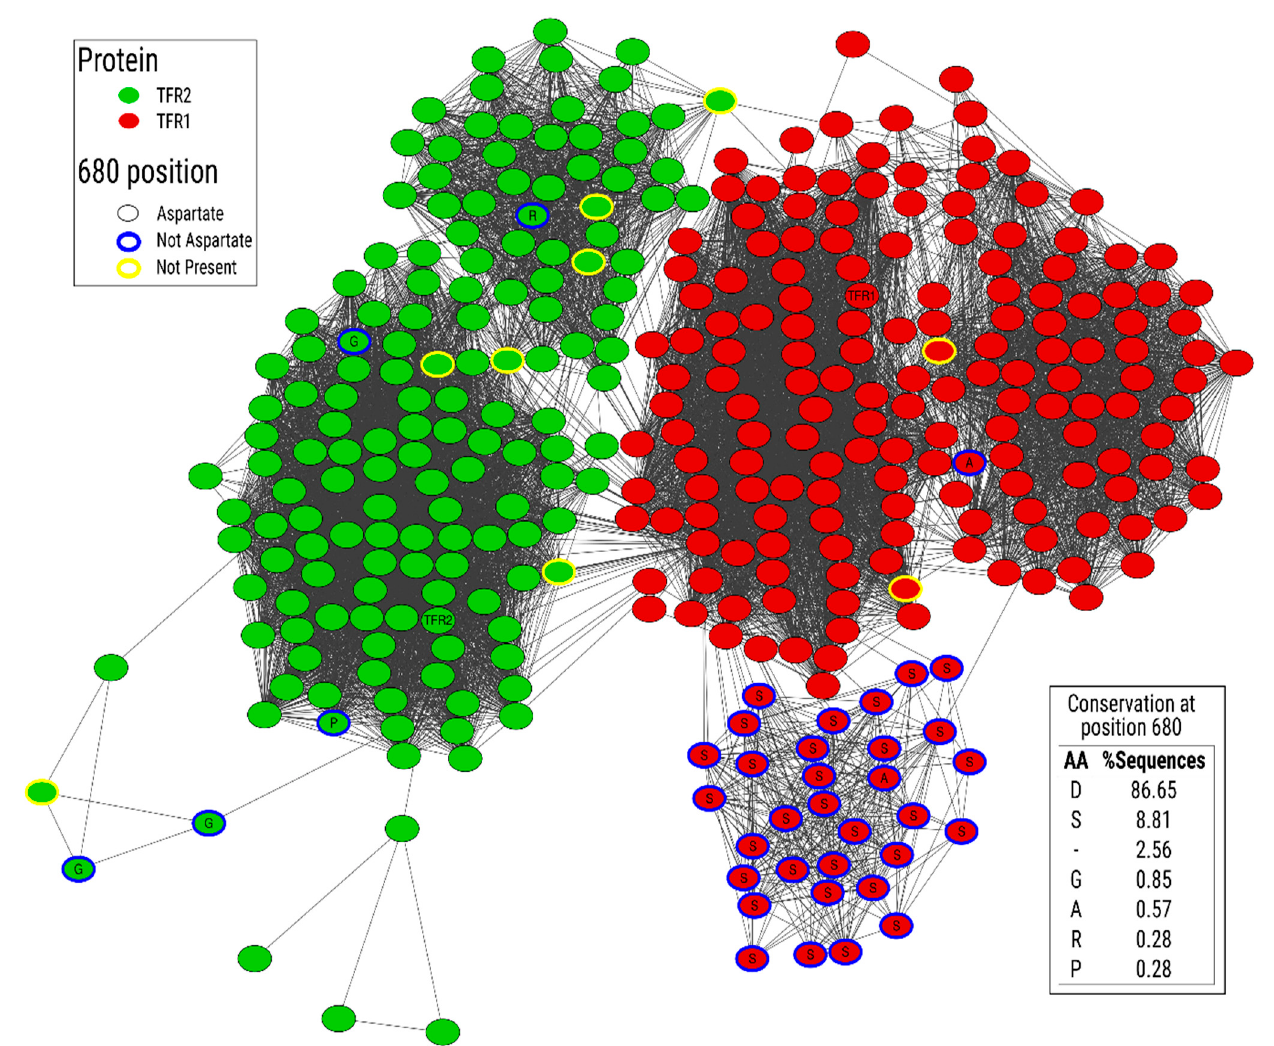
Figure A2. Sequence similarity network for TFR1 and TFR2 orthologous proteins. Three hundred fifty-two sequences were used, where each node represents an orthologous sequence to the human TFR1 (red nodes) or TFR2 (green nodes) proteins. Edges are drawn between two nodes if their sequence similarity is higher than 0.59. Node border colors indicate amino acid identities of positions aligned with the human TFR2 position 680. Sequences with aspartate at this position have thin black borders. Sequences with an identity different from aspartate appear with thick blue borders. Finally, sequences with no residue aligned at this position appear with yellow node borders. Nodes representing the human TFR1 and TFR2 sequences have labels indicating their protein name. The right bottom table indicates the percentage of sequences bearing a particular amino acid identity (or lack of it: ‘-’) at the position aligned with the human TFR2 position 680.